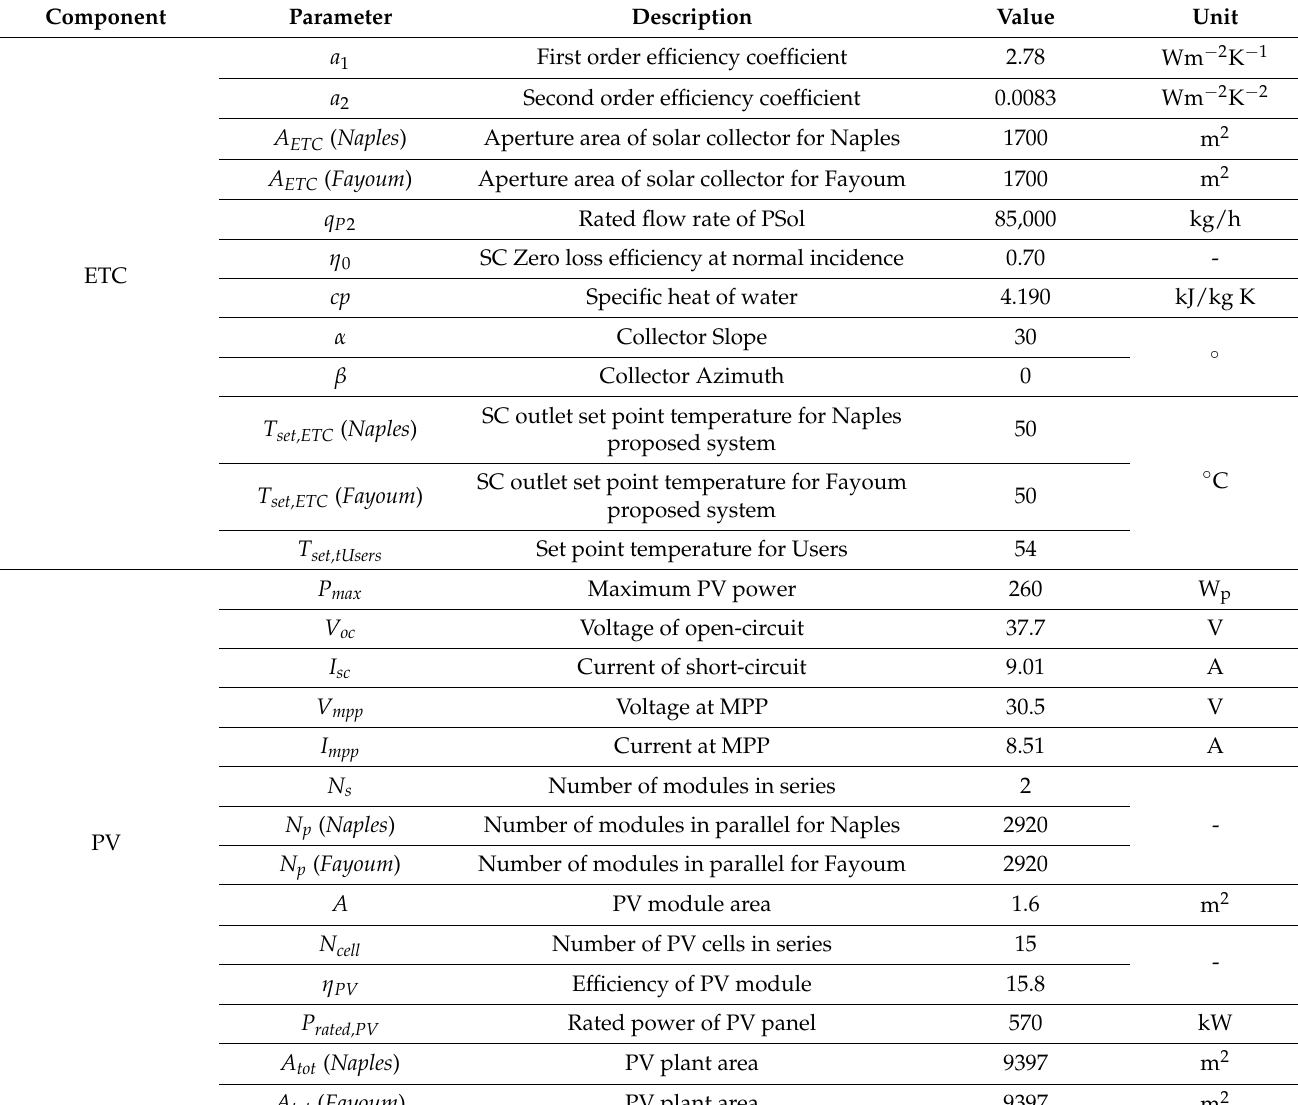
Table 1. The design and operating parameters of the system components. ETC: evacuated tube collectors and PV: photovoltaic.